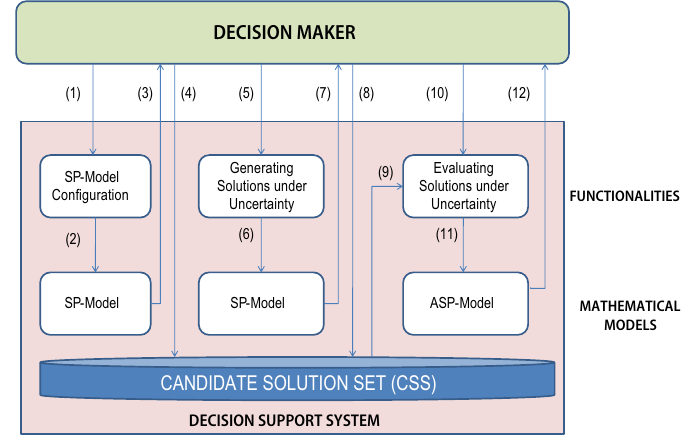
Fig. 1. Interaction among the main actors involved in the LHP reallocation